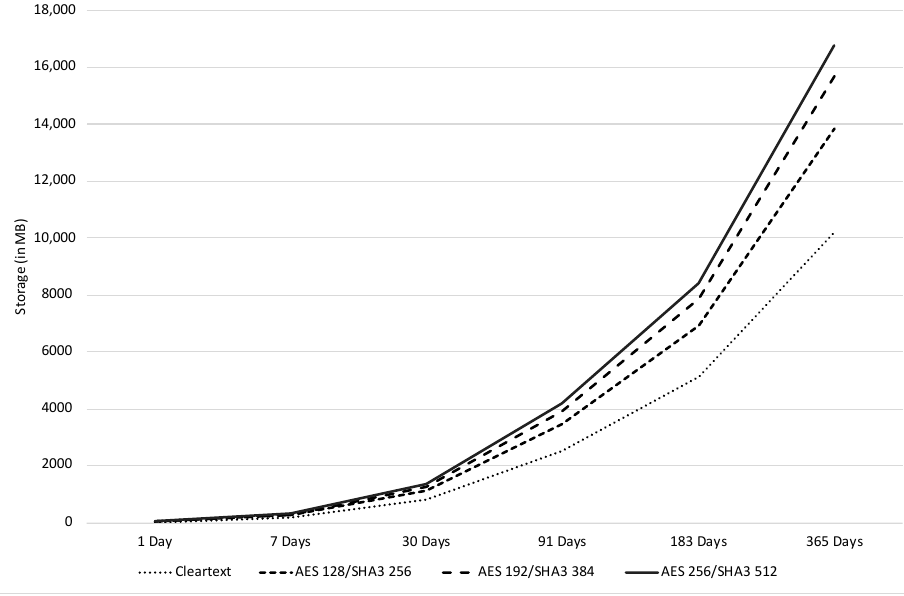
Figure 5. Storage requirements per key